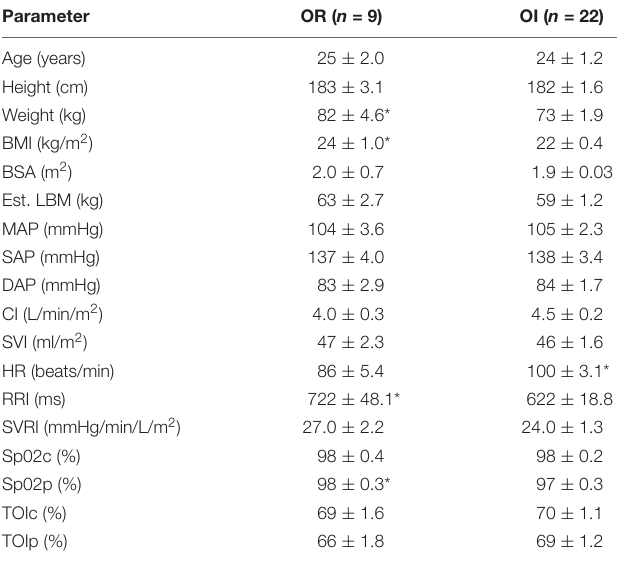
TABLE 1 | Baseline (P0) anthropometric, cardiovascular, and central/peripheral oxygenation parameters between OR and